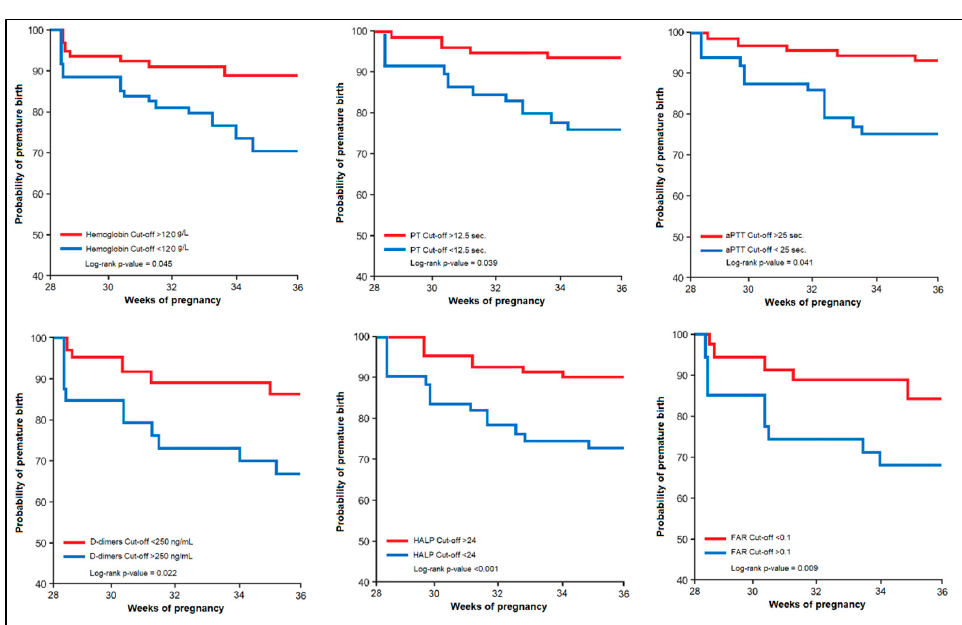
Figure 3. Kaplan–Meier plot for the estimated probability of preterm birth.